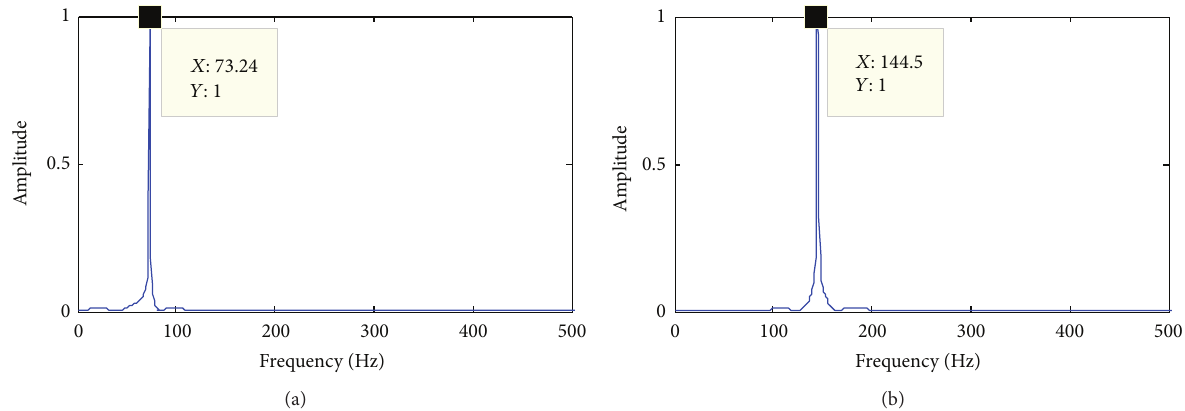
Figure 7: (a) Fault characteristic frequency and (b) twice the fault characteristic frequency.